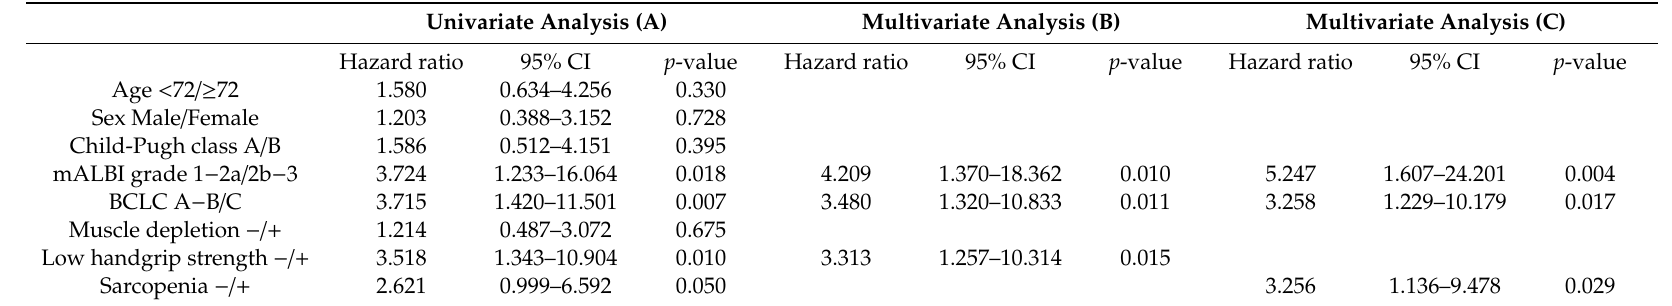
Table 2. Univariate and multivariate analyses of factors associated with overall